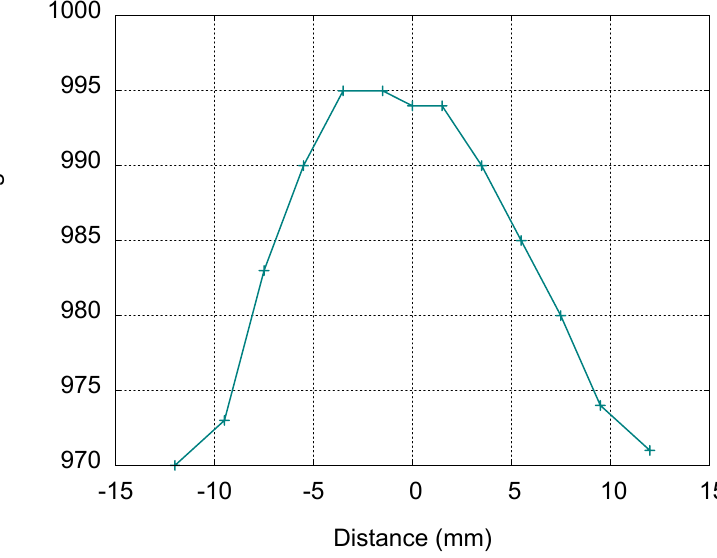
Figure 16. Measurement of sensor output for different positions of the steel